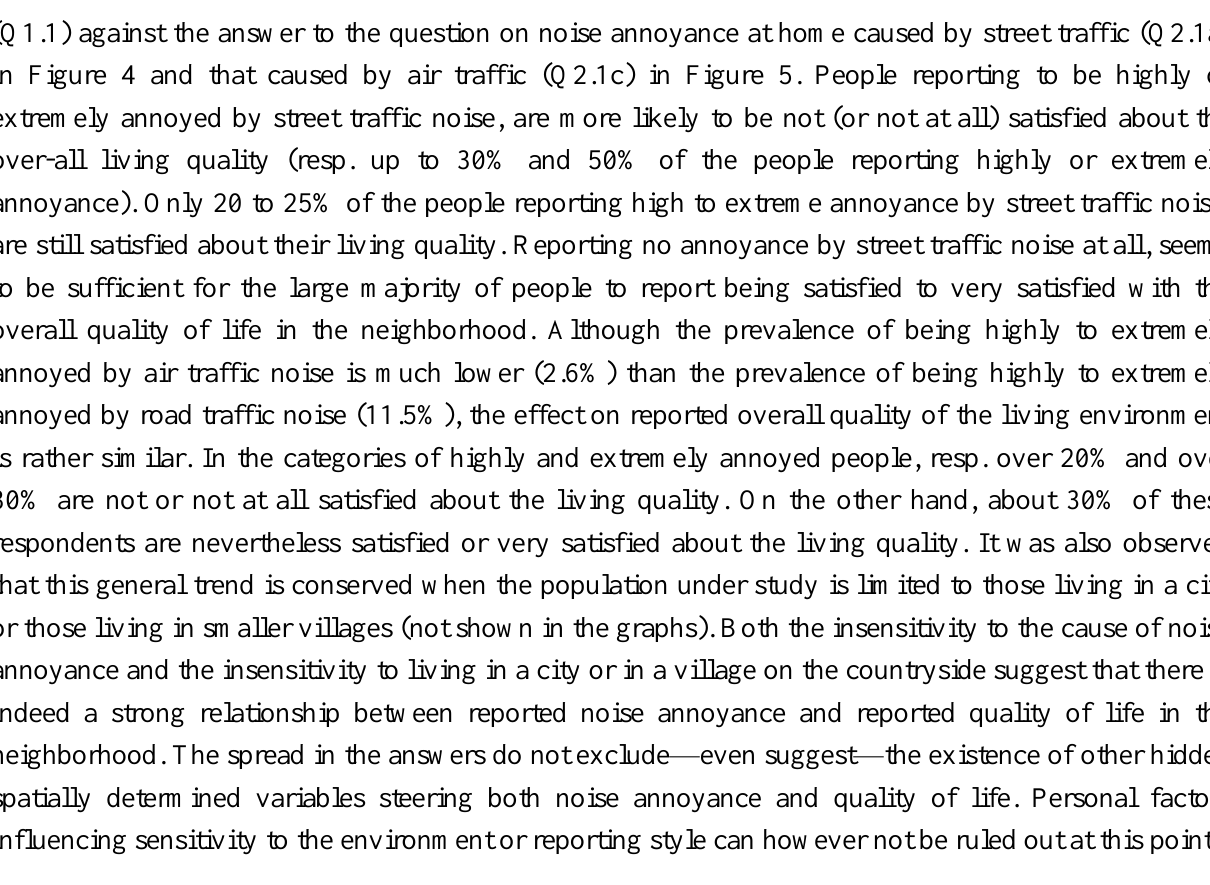
Figure 4. The influence of reported street traffic noise annoyance (Q2.1a) (horizontal)